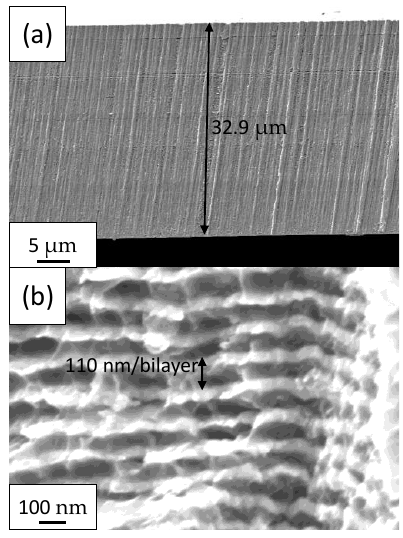
Figure 2. ( a ) SEM image showing the total as-fabricated RMF thickness and ( b ) the bilayer thickness (white is Ni and grey is Al).